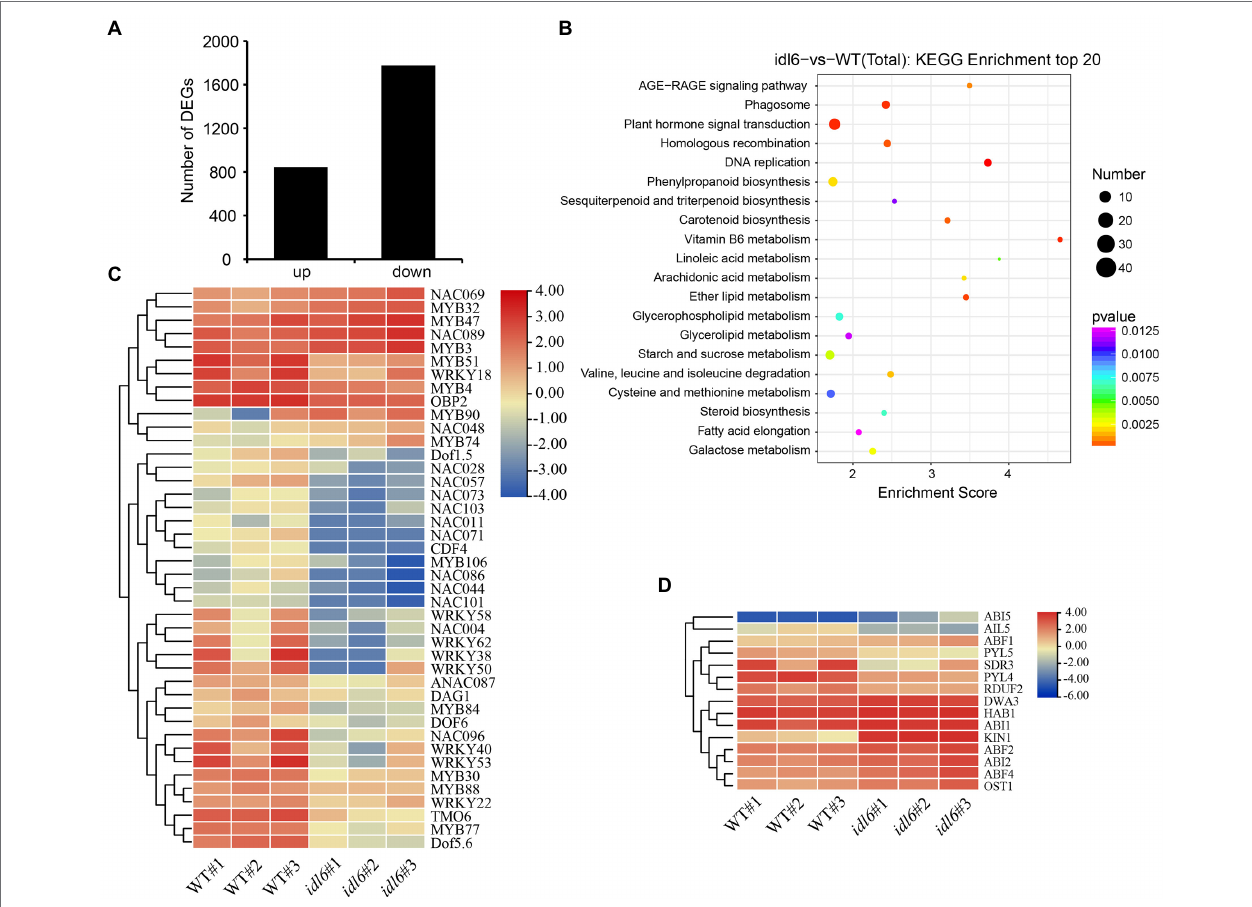
FIGURE 6 | Genome-wide transcriptome analysis of idl6 mutant plants. (A) The number of up-regulated and down-regulated genes in rosette leaves of idl6 mutant vs. Col-0. (B) KEGG bubble diagram of the DEGs in rosette leaves of idl6 vs. Col-0. Bubble size represents numbers of DEGs, and bubble color represents p - values. The enrichment score represents the significance degree of DEGs in a certain signaling pathway. (C) Heatmap showing leaf senescence-related transcription factors in idl6 mutant leaves compared with Col-0. The log2 fold change scale is indicated on the right side of the heatmap. (D) The heatmap of ABA-related genes in idl6 mutant leaves compared to Col-0. The log2 fold change scale is indicated on the right side of the